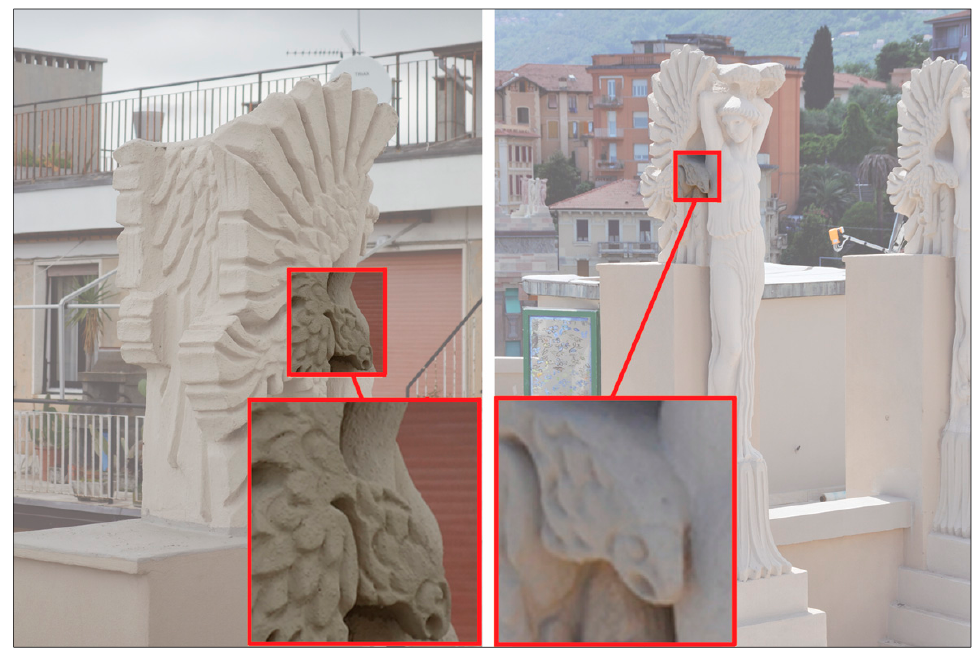
Figure 5. Details of the same size show how distance affects photo resolution.